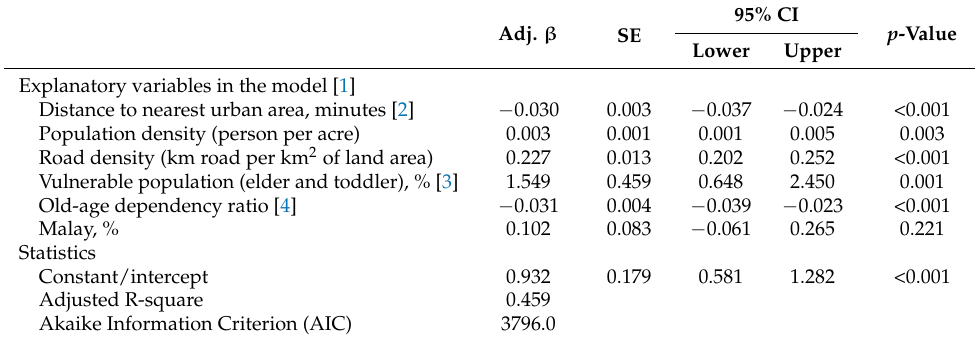
95% CI p -Value Adj. β SE Lower Upper